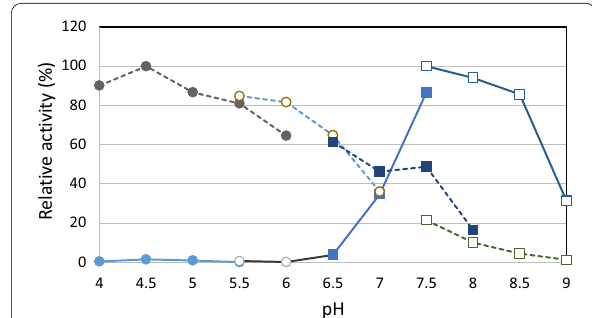
Fig. 3 Effect of pH on the activity of purified Lcc120-3 (Mic-mg-MCO) for ABTS and DMP. Closed circles indicate acetate buffer (pH 4.0–6.0), open circles indicate citrate-NaOH buffer (pH 5.5–7.0), closed squares indicate KPB (pH 6.5–8.0), and open squares indicate Tris–HCl buffer (pH 7.5–9.0). The dotted line indicates the activity for ABTS, and the solid line indicates the activity for DMP. Relative activity is shown as 100% at each optimal pH